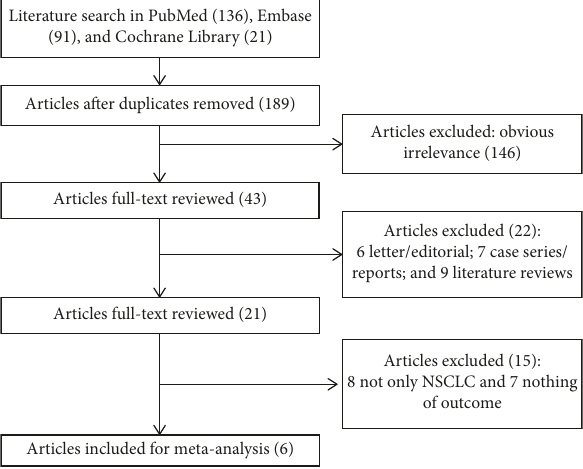
Figure 1: Flow diagram of the study selection